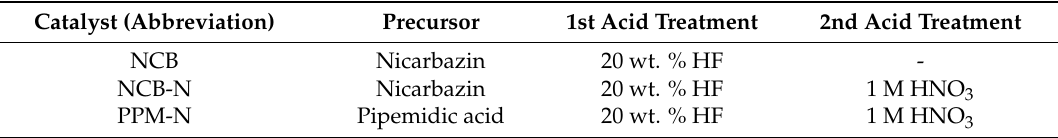
Table 1. Synthesized Fe-N-C